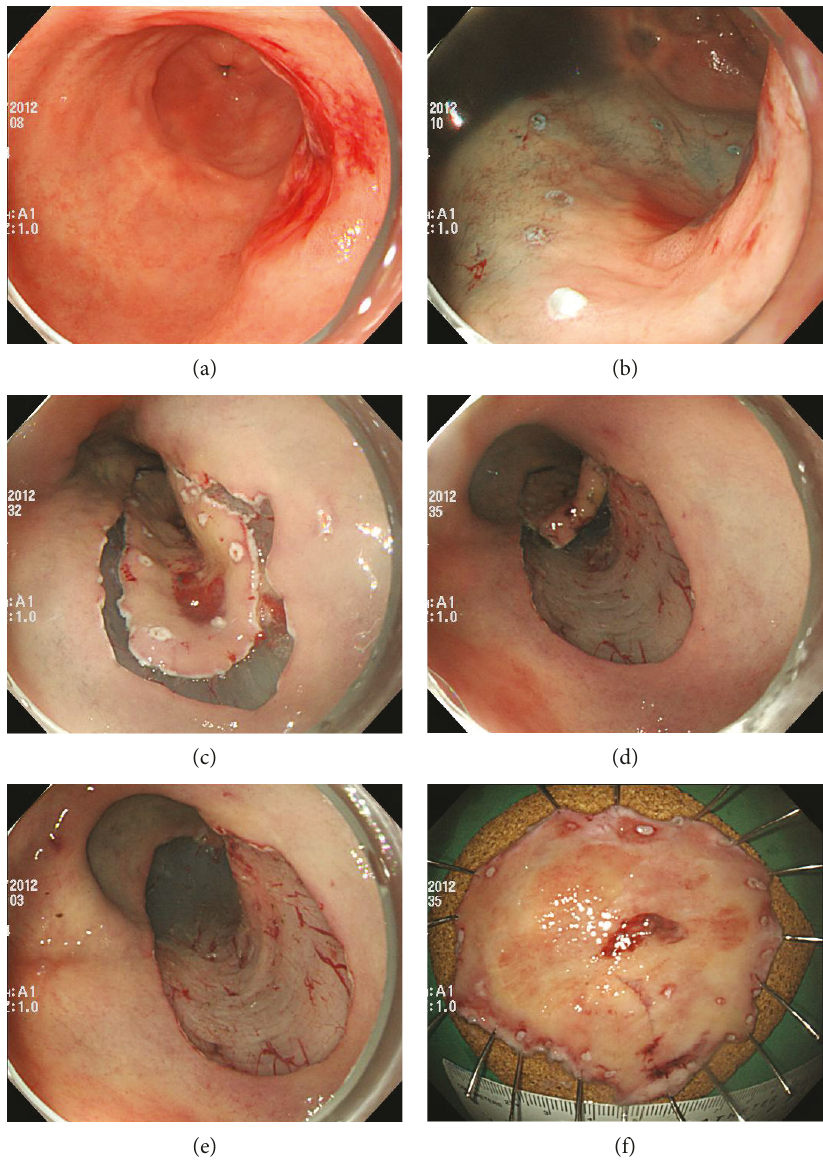
Figure 1: Endoscopic submucosal dissection for early gastric cancer in the gastric conduit, after esophagectomy. (a) A slightly depressed lesion is observed in the gastric conduit. (b) Circumferential marking is performed around the tumor using argon plasma coagulation. (c) A circumferential mucosal incision is made outside the marking dots with an electrosurgical knife. (d) Submucosal dissection is performed with an electrosurgical knife. (e) The lesion is completely removed. (f) Resected